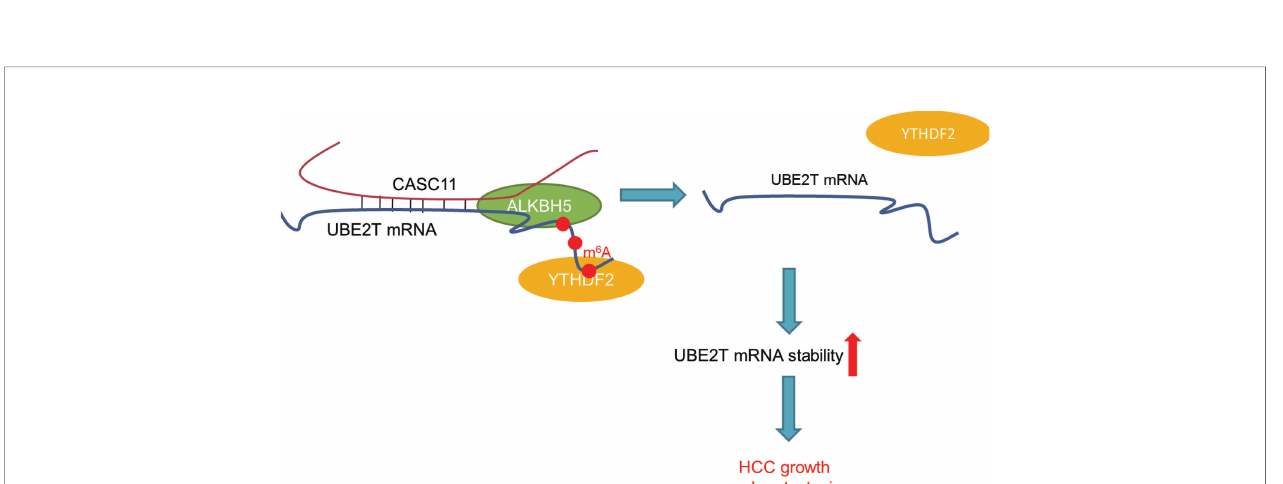
FIGURE 8 | The schematic model of CASC11 promotes HCC progression and its functional